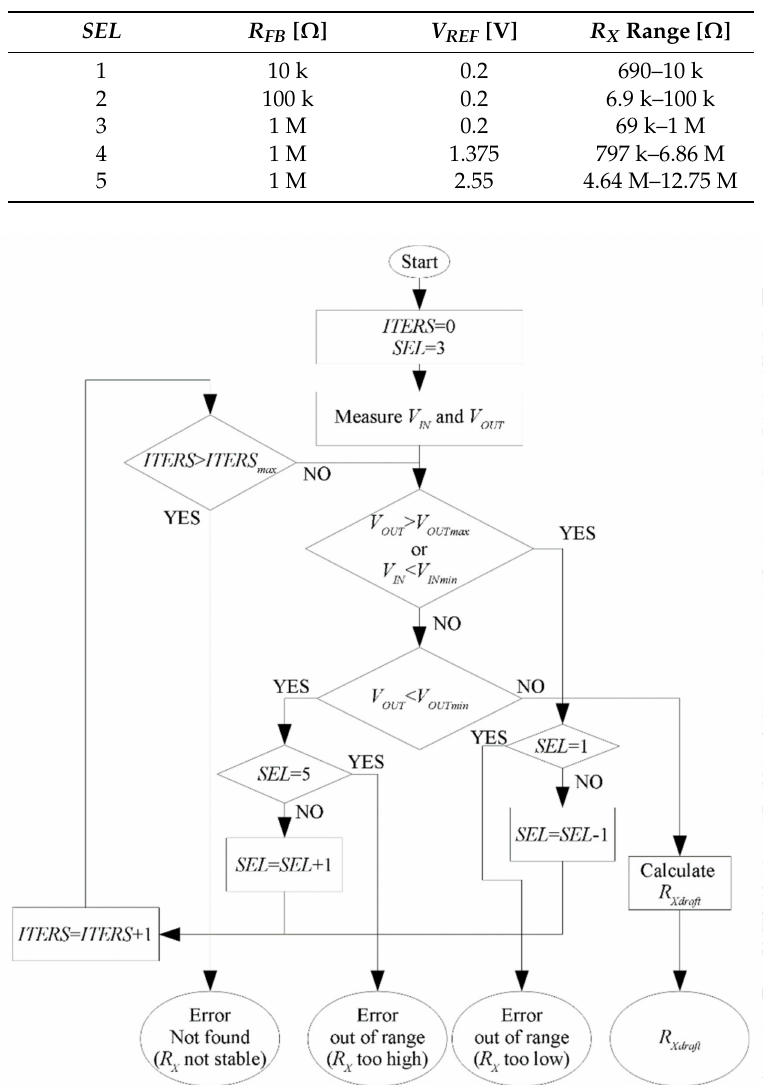
Figure 2. The algorithm used in the measurement of R Xdraft . The values of SEL represent the preselected sets of the R FB and V REF for draft measurement and they are explained in Table 1, V INmin = 25 mV, V OUTmax = 3.1 V, ITERS max =